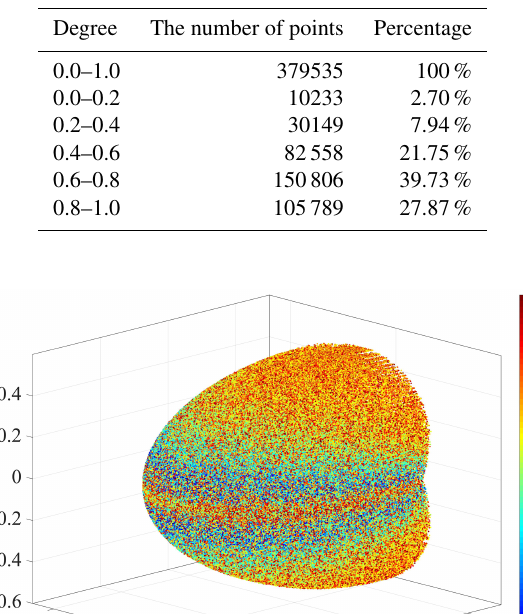
Table 7. Relative manipulability value of the HMCCM.